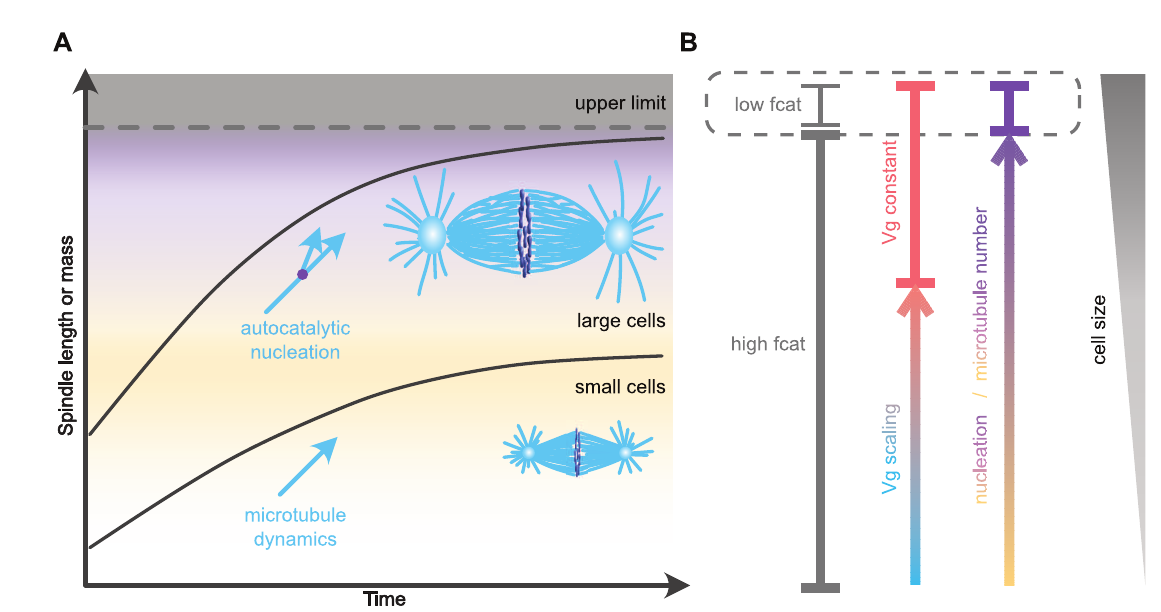
Figure 2. Mechanisms of spatial and temporal control of spindle assembly and scaling. ( A ) In large embryos, spindle size reaches an upper limit and does not scale with cell size [3,10]. As cell size decreases, spindle size adapts to cell dimensions through the regulation of microtubule nucleation [8]. This mechanism might allow cells to maintain the duration of spindle assembly constant. In small cells, microtubule dynamics and especially growth velocity scales with cell size and regulates microtubule and spindle length [7,8]. In C. elegans , this mechanism allows for the duration of spindle assembly to be constant and independent of cell size [7]. ( B ) Potential regulation of distinct microtubule parameters with cell size. The variation in catastrophe frequency (fcat) is based on observations made in Xenopus stage 3 and stage 8 embryo extracts, representing large- and small-cell regimes, respectively [9]. Microtubule nucleation scales over a wide range of sizes [8]. In small cells, microtubule growth velocity (Vg) scales with cell size and becomes constant in larger cells